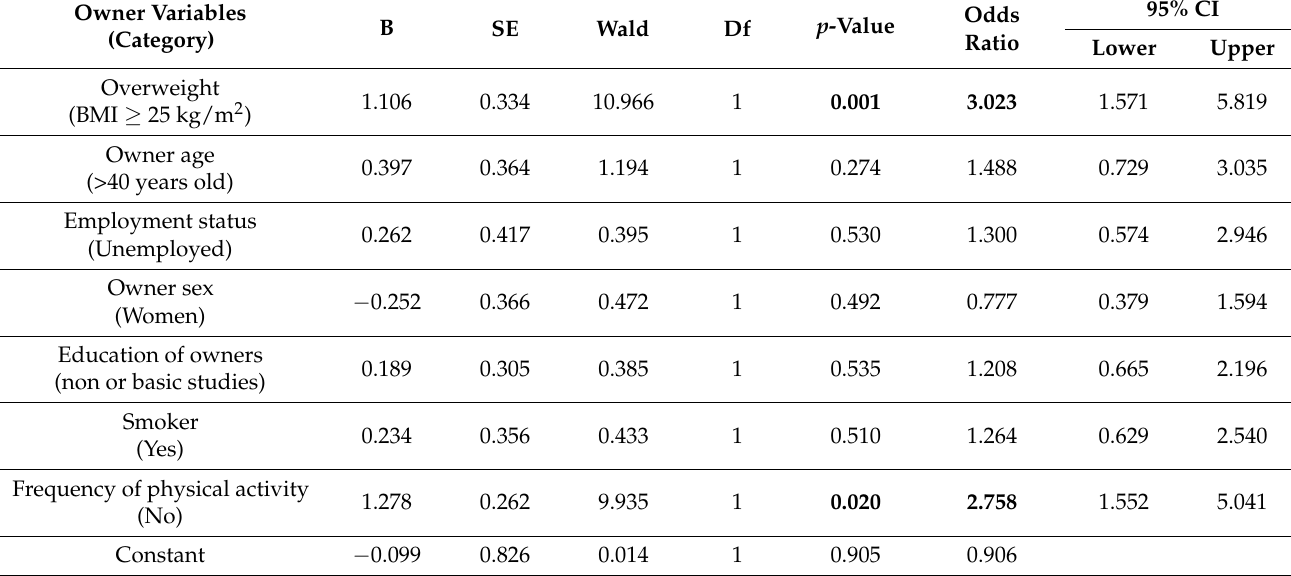
Table 3. Results of the logistic regression analysis completed for the study of the association between the overweight/obesity of dogs and the different owner variables’ categories